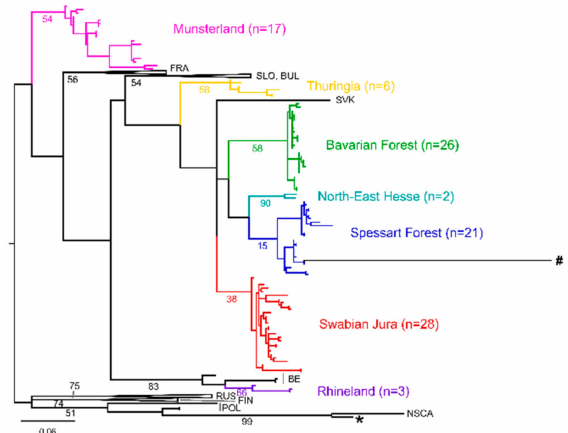
Figure2. PhylogeneticanalysisofPuumalavirusLsegmentsequences. Colorsindicatephylogeographic clusters in Germany. The maximum likelihood (ML) tree based on a 288 nt alignment, calculated using the GTR + G model of nucleotide substitution is shown. The tree is midpoint rooted. The scale bar indicates nucleotide substitutions per site. Bootstrap values (500 iterations) are given in percent for relevant clades. Sequences marked with a star and hash stem from patients with reported travel history abroad.